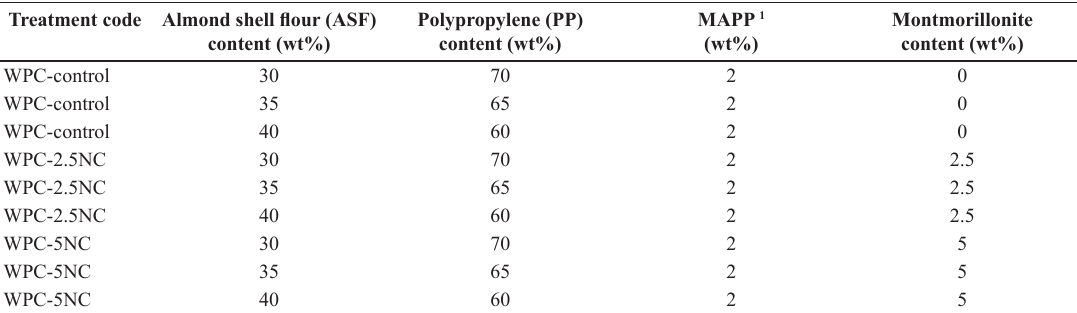
Table 1. WPC formulations for the composition of the studied formulations. Treatment code Almond shell flour (ASF) content